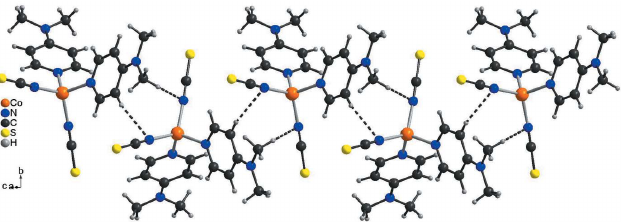
Figure 5 Crystal structure of form II with a view of a chain with intermolecular C— H (cid:2)(cid:2)(cid:2) S hydrogen bonding shown as dashed lines.